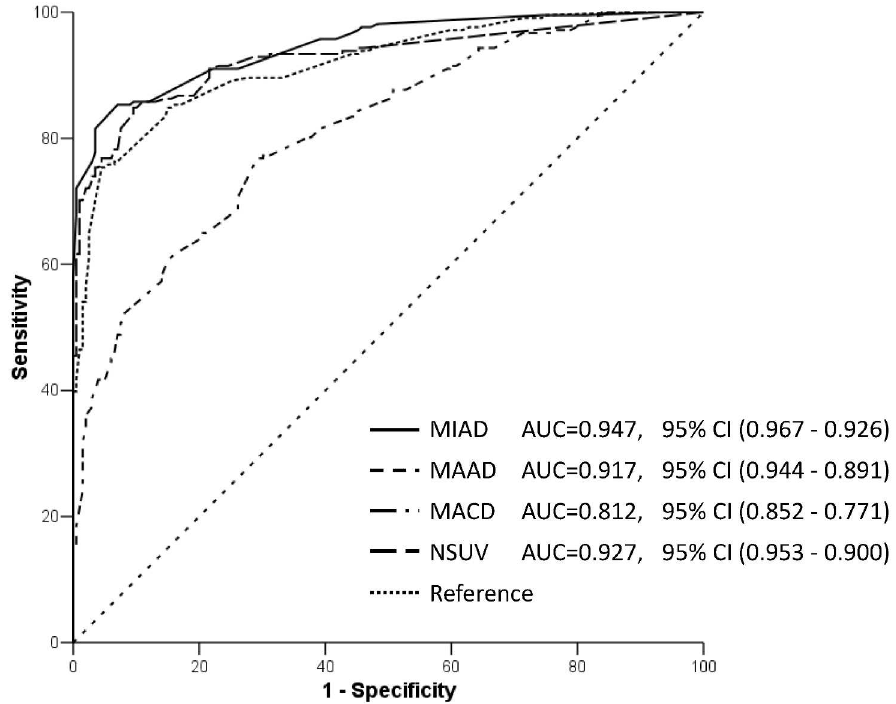
Fig 6. ROC curves of parameters in stage II. ROC curves of the three nodal diameters: MIAD, MAAD, MACD, and NSUV. Some overlap of 95%CIs of the area under the curves of the MIAD, MAAD, and NSUV is evident. MIAD, minimal axial diameter; MAAD, maximal axial diameter; MACD, maximal coronal diameter.